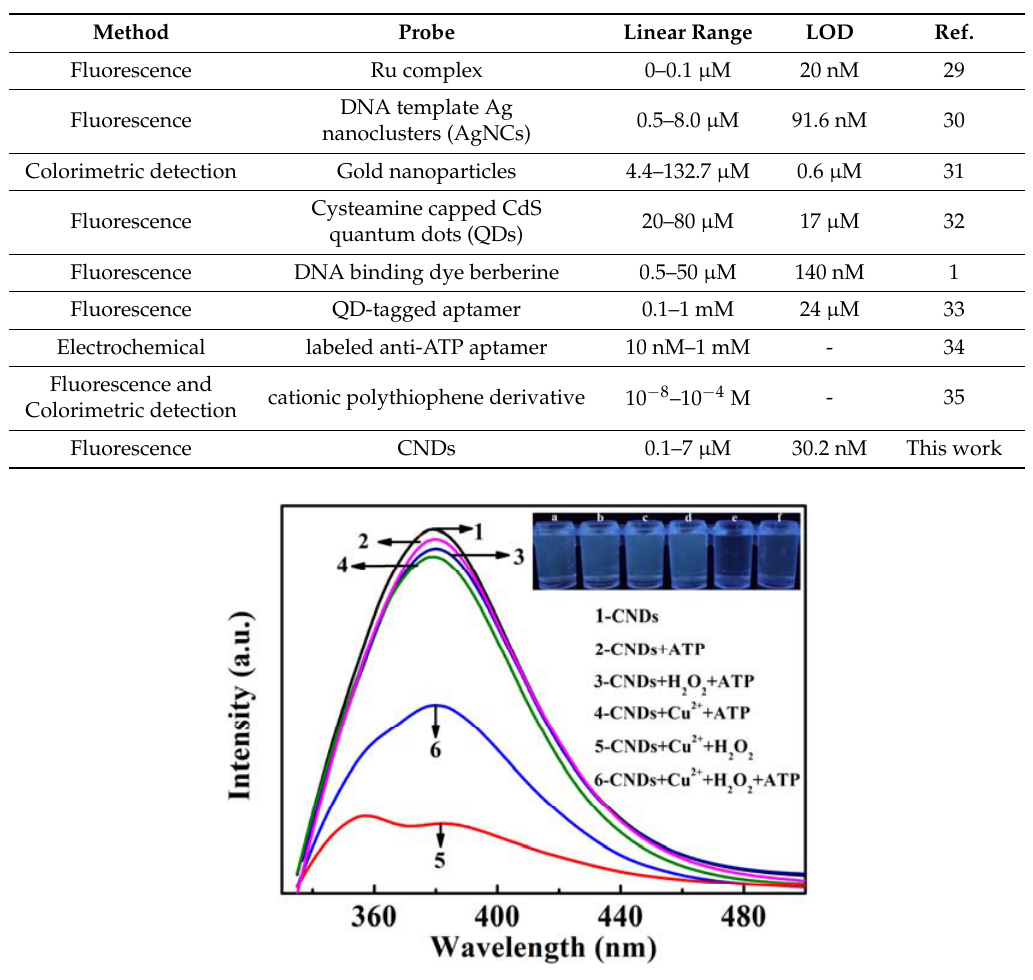
Figure 3. Fluorescence spectra of free CNDs ( 1 ) and CNDs in the presence of ATP ( 2 ), H 2 O 2 and ATP ( 3 ), Cu 2+ and ATP ( 4 ), Cu 2+ and H 2 O 2 ( 5 ) and Cu 2+ , H 2 O 2 , and ATP ( 6 ). The final concentrations of CNDs, H 2 O 2 , Cu 2+ , and ATP were 0.014 mg/mL, 5 mM, 600 nM and 7 μ M respectively. The inset shows the corresponding images under UV light.